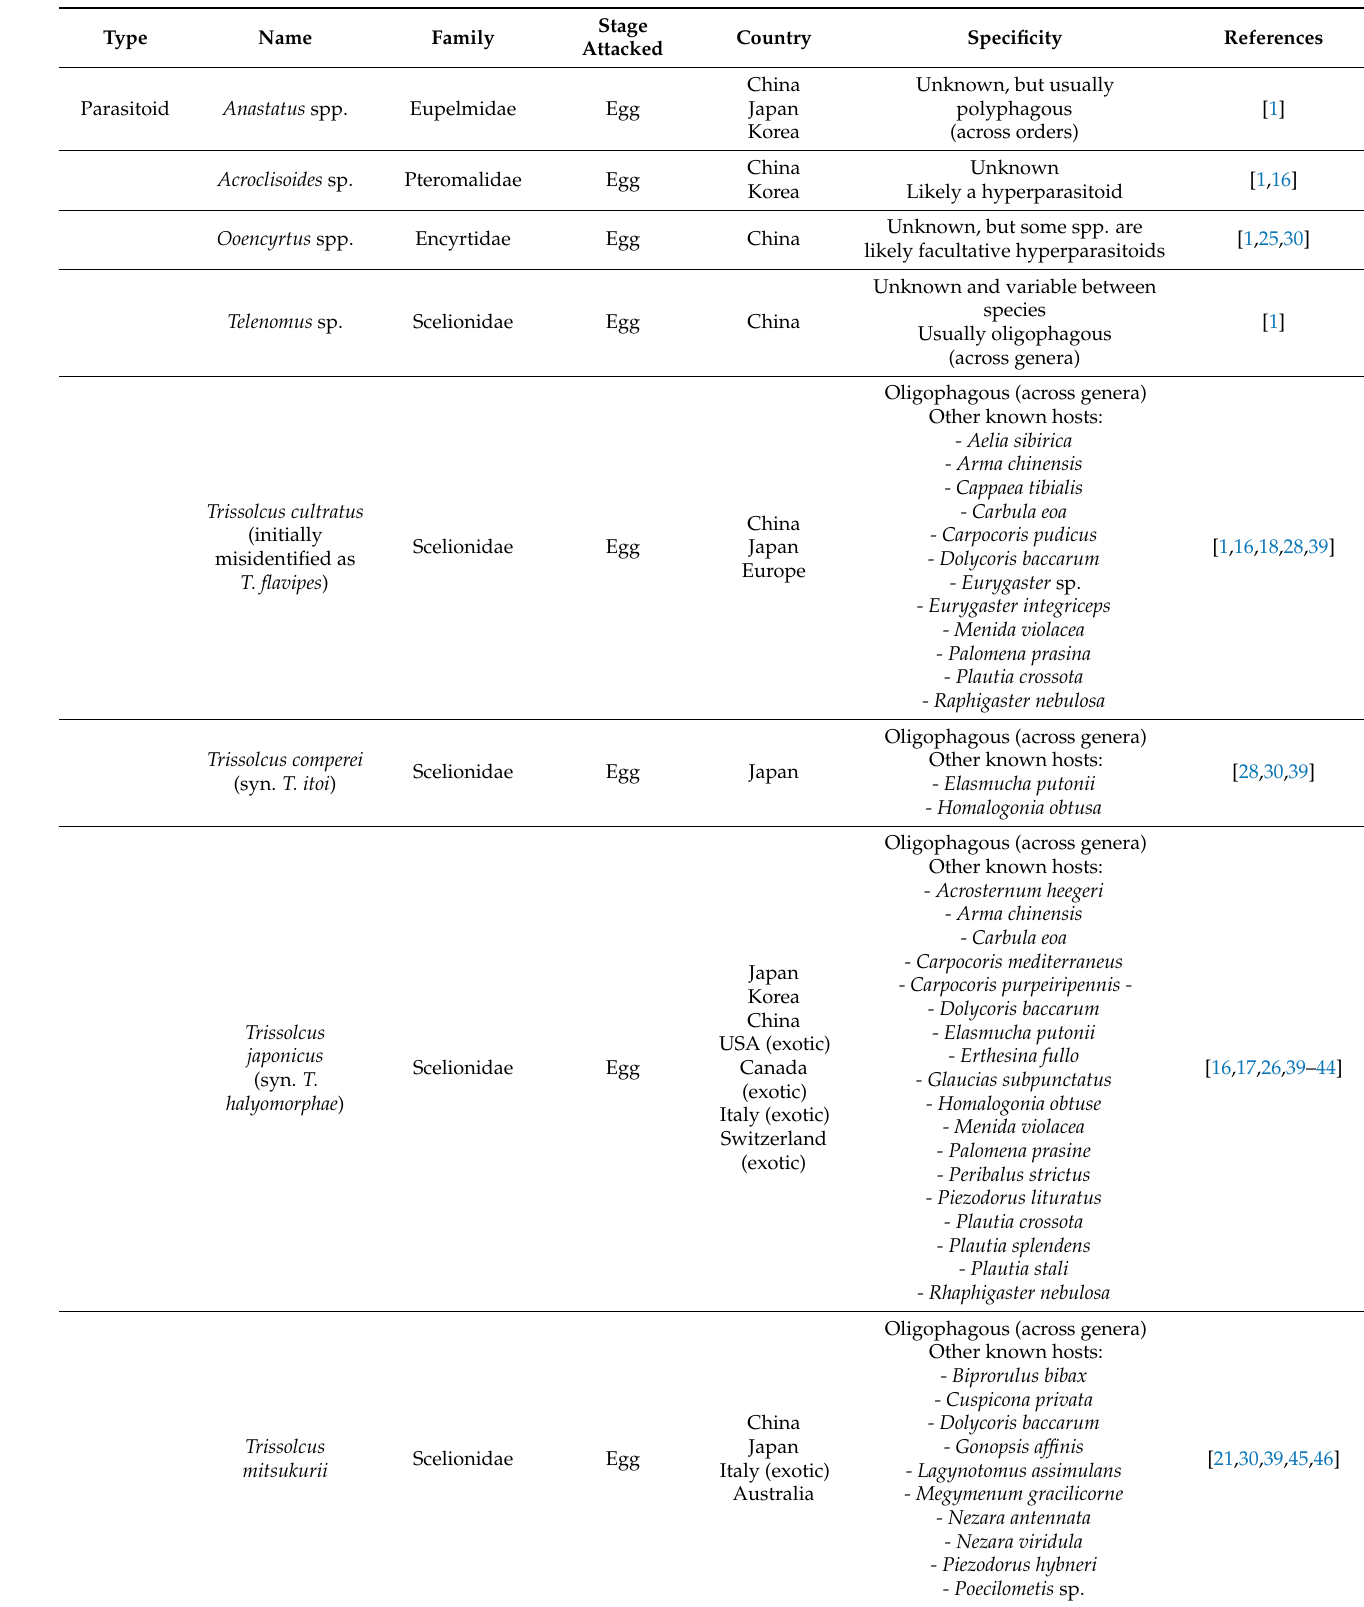
Table 1. Natural enemies of Halyomorpha halys found in the native range, showing host stage attacked, country of occurrence (including exotic locations), and host specificity level, including known